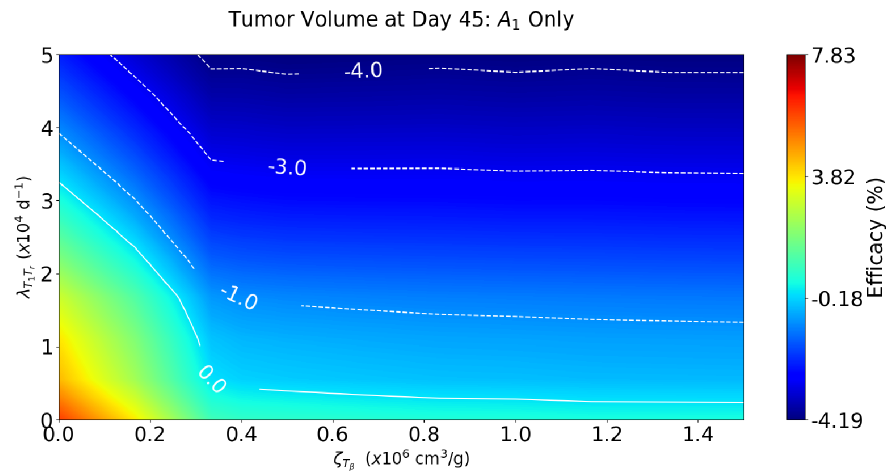
Fig 3. Combined effect of cancer-specific parameters l g ¼ 10 (cid:0) 8 g = cm 3 � d . The color column indicates relative difference of the tumor volume at day 45. Negative values A 1 represent parameter ranges of tumor